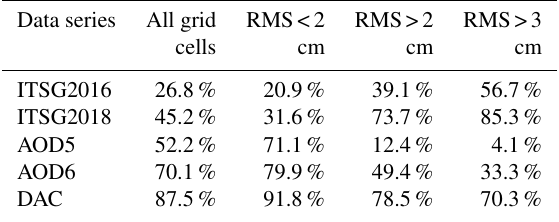
Table 2. Percent of non-coastal ocean area where the altimetric vari- ance is better explained by the given time series than by the CSR swath series. The 2 and 3cm RMS bounds are defined in Fig. 3a. Data